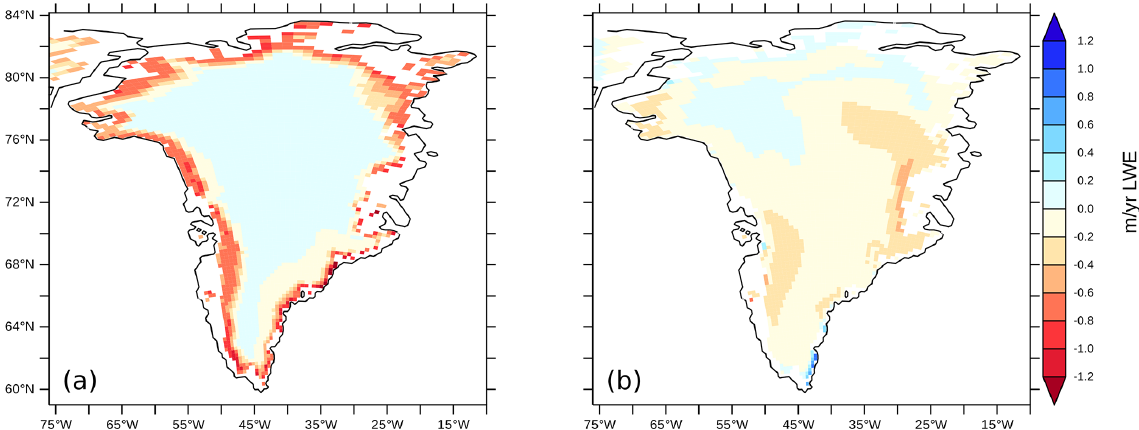
Figure 8. Change in annual average surface mass balance (myr − 1 LWE) for the surface of Greenland between the MIROC5 climate for 2080–2099 under RCP4.5 and the 1980–1999 climate shown in Fig. 6. (a) MAR (minimum change 1.48; maximum 0.08), (b) FAMOUS-ice (minimum change − 0.73; maximum 0.92). To visualise the distribution on sub-grid-scale tiles, FAMOUS-ice results have been trilinearly mapped to the same topography as used in